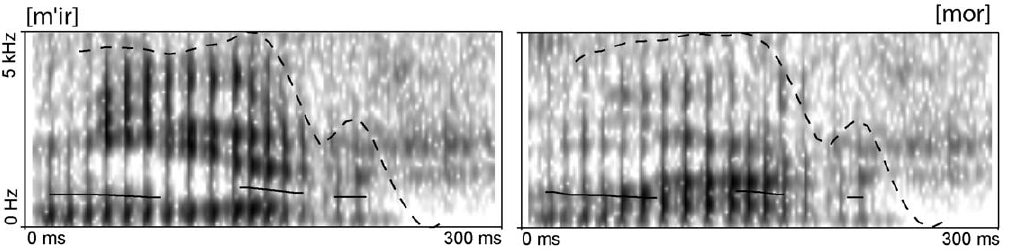
Figure 1. Spectrograms of the high- frequency (mir) and low-frequency (mor) words used in the experiments. The triphonemic consonant-vowel-consonant stimuli were maximally matched acoustically. Note the high similarity between the pitch (solid black line) and intensity (dashed line) contours of the two stimuli.